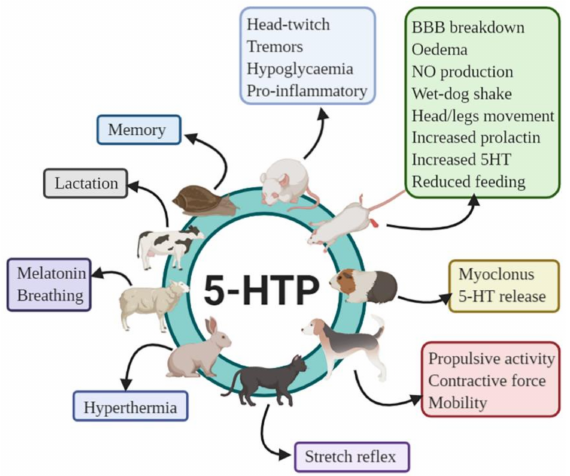
Figure 10. Summary of effects of 5-HTP on some animals. In terrestrial snails, 5-HTP reinstates the context memory, whereas in mice, 5-HTP produces a characteristic head twitch and tremors, induces hypoglycemia, and suppresses inflammation by inducing pro-inflammatory mediators. In rats, most of the listed effects of 5-HTP are dose dependent. In guinea pigs, 5-HTP enhances myoclonus and facilitates the luminal 5-HT release. In dogs, 5-HTP increases propulsive activity, contractive force, and mobility index. Injection of 5-HTP facilitates the stretch reflex in cats and produces a fall in temperature in rabbits. In sheep, 5-HTP increases serum melatonin and foetal breathing movements and stimulates an autocrine–paracrine adaptation to lactation in cows. Created with